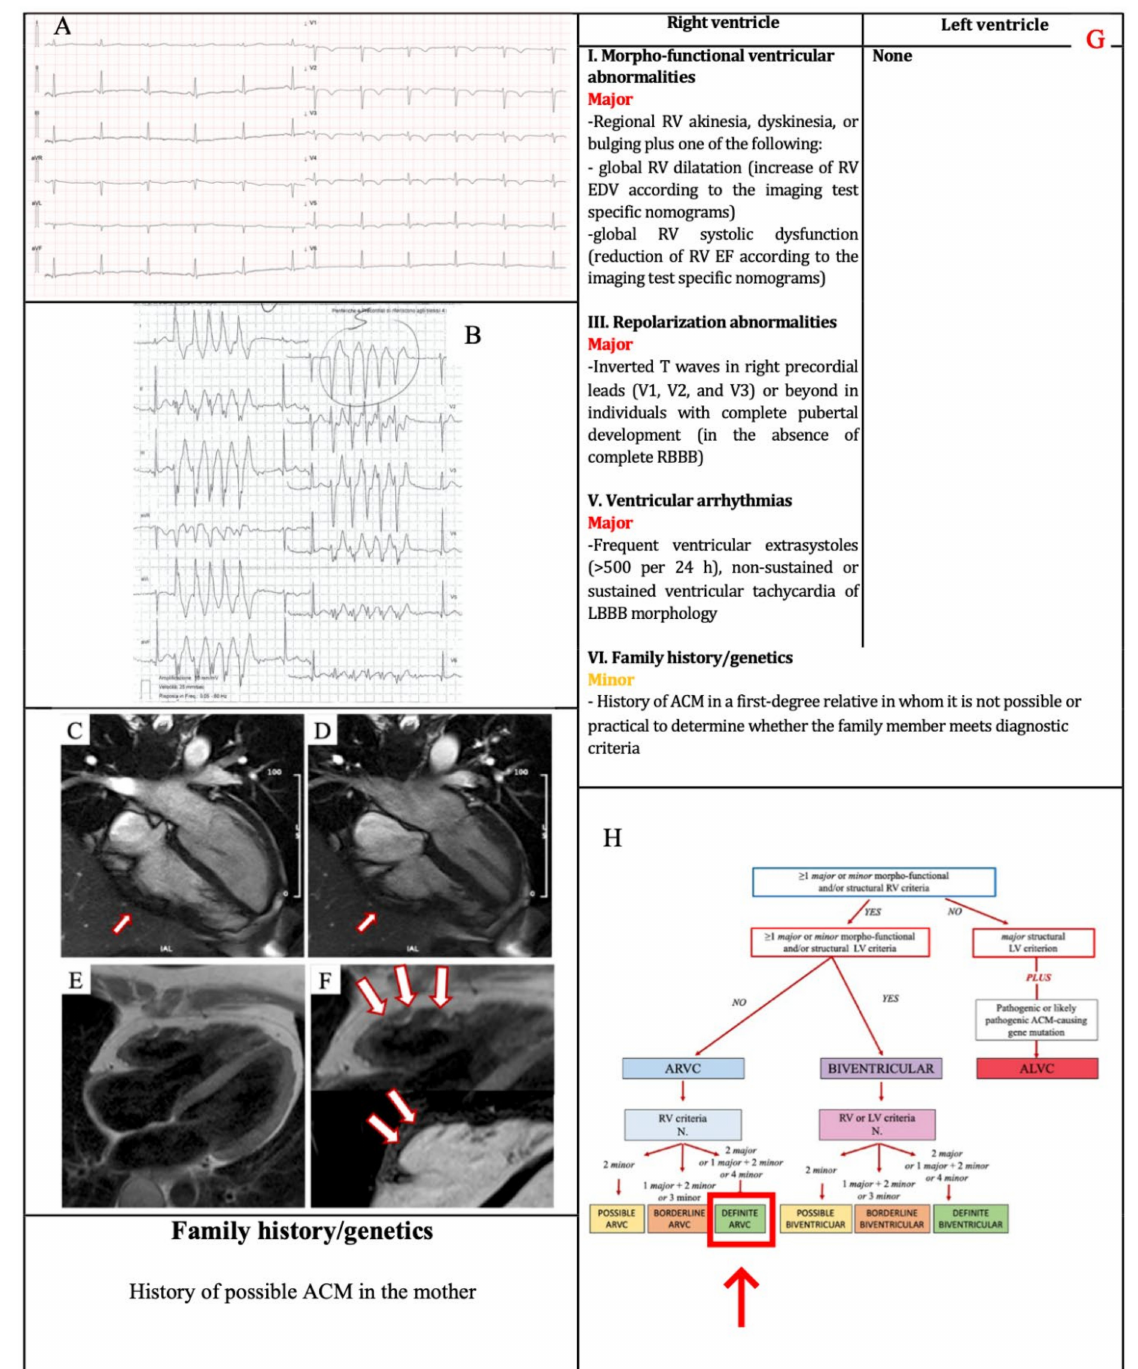
Figure 2. Example 1. ( A ) ECG. TWI in V1–V5 and flattened T wave in inferior leads. ( B ) Exercise testing. NSVT with LBBB/superior axis morphology. CMR. Four-chamber cine view in diastolic phase ( C ) and systolic phase, ( D ) : a wide peri-tricuspid aneurysm, with an extreme thinning of the wall (arrows). PD-TSE four-chamber view for fat evaluation, ( E ) : fatty infiltration of the RV wall, in particular in the subtricuspid region (magnified on the top of F , arrows) On the corresponding postcontrast sequences ( F on the bottom, arrows) the presence of RV LGE in the same region of fatty infiltration could not be evidenced. The 2020 Padua criteria achieved by the patient ( G ). Diagnostic flowchart for ACM phenotypic variants [12] ( H ). In the red box, the diagnosis of the patient. ACM = arrhythmogenic cardiomyopathy; CMR = cardiac magnetic resonance; LBBB = right bundle branch block; LGE = late gadolinium enhancement; NSVT = non-sustained ventricular tachycardia; PD–TSE = proton density-weighted turbo spin-echo; RV = right ventricle; TWI = T wave